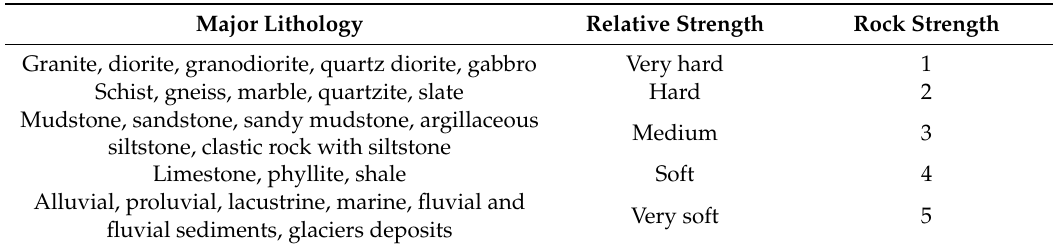
Table 1. Lithology composition and classification of the study